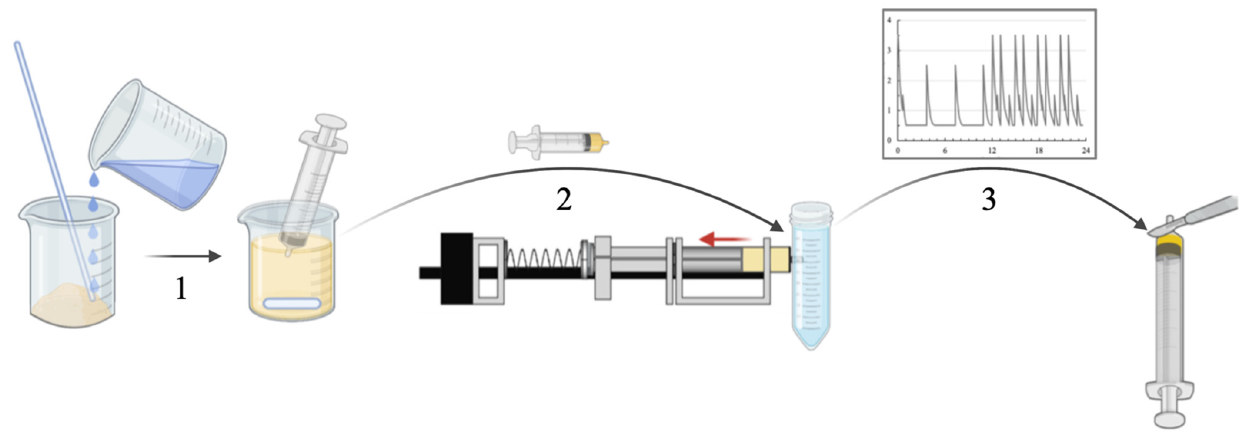
Figure 5. Graphical illustration of dosing procedure 1—transferring suspensions to syringe; 2—placing syringe in the in vitro model; 3—repeating daily dosing procedure (steps 1 and 2) including completion of the volume pattern until agglomerate formation is completed and agglomerates can be extracted by cutting the syringe cylinder with a scalpel.